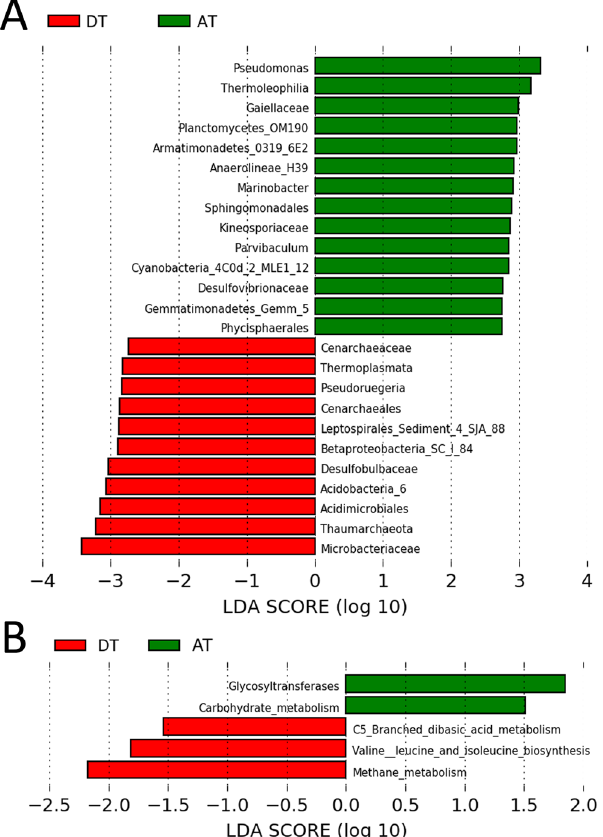
Figure 3. Differential bacterial and archaeal compositions comprise chronically diseased tissue and adjacent tissue. (A ) LDA Effect Size (LEfSe) plot of taxonomic biomarkers identified within chronically diseased tissue (DT) and adjacent tissue (AT) samples. Red bars are indicative of enrichment within DT samples, whereas green bars are indicative of enrichment within AT samples. A Kruskal-Wallis test was employed at an alpha = 0.05 to identify significantly enriched taxa, whereas a pairwise Wilcoxon rank sum test was utilized to test biological consistency across all subgroups (alpha = 0.05). A linear discriminant analysis (LDA) was calculated to determine effect size and we present all taxa that yielded an LDA score > 1.5. A total of 33 taxa (25 being taxonomically identified) were found to be enriched in both sample groupings. (B ) PICRUSt-inferred metagenomics and LEfSe predicted-function enrichment plots. Functions with an LDA score > 1.5 are shown. Inferred molecular function of the bacterial populations identified by 16S rRNA gene sequencing are stratified by tissue type (chronically diseased tissue (DT) and adjacent tissue